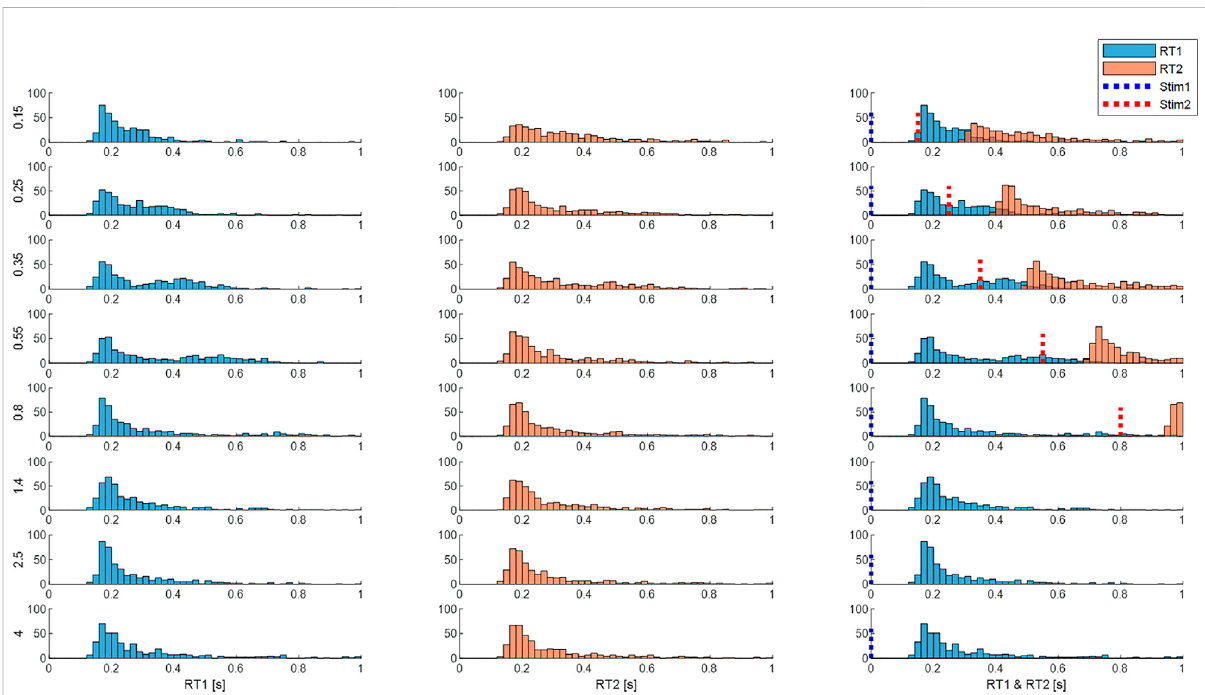
FIGURE 10 Response times are affected by inter-stimulus interval (ISI). Panels show distribution of size integrated delays from M3 (both processes). Rows: ISI 0.15 — 4 s. Column 1 (RT1). Column 2 (RT2). Column 3 (RT1 and RT2 related to stimulus 1 onsets). Blue dotted line represents the onset of the fi rst stimuli and the red line represents the onset of the second stimuli. Each subplot shows the number of cases ( y -axis) for each latency ( x -axis). Each row shows distribution for each ISI (vertical left label 0.15 – 4 s). Message: RT1 and RT2 distributions are similar at large ISI. At short ISI, RT2 distribution is longer and fl